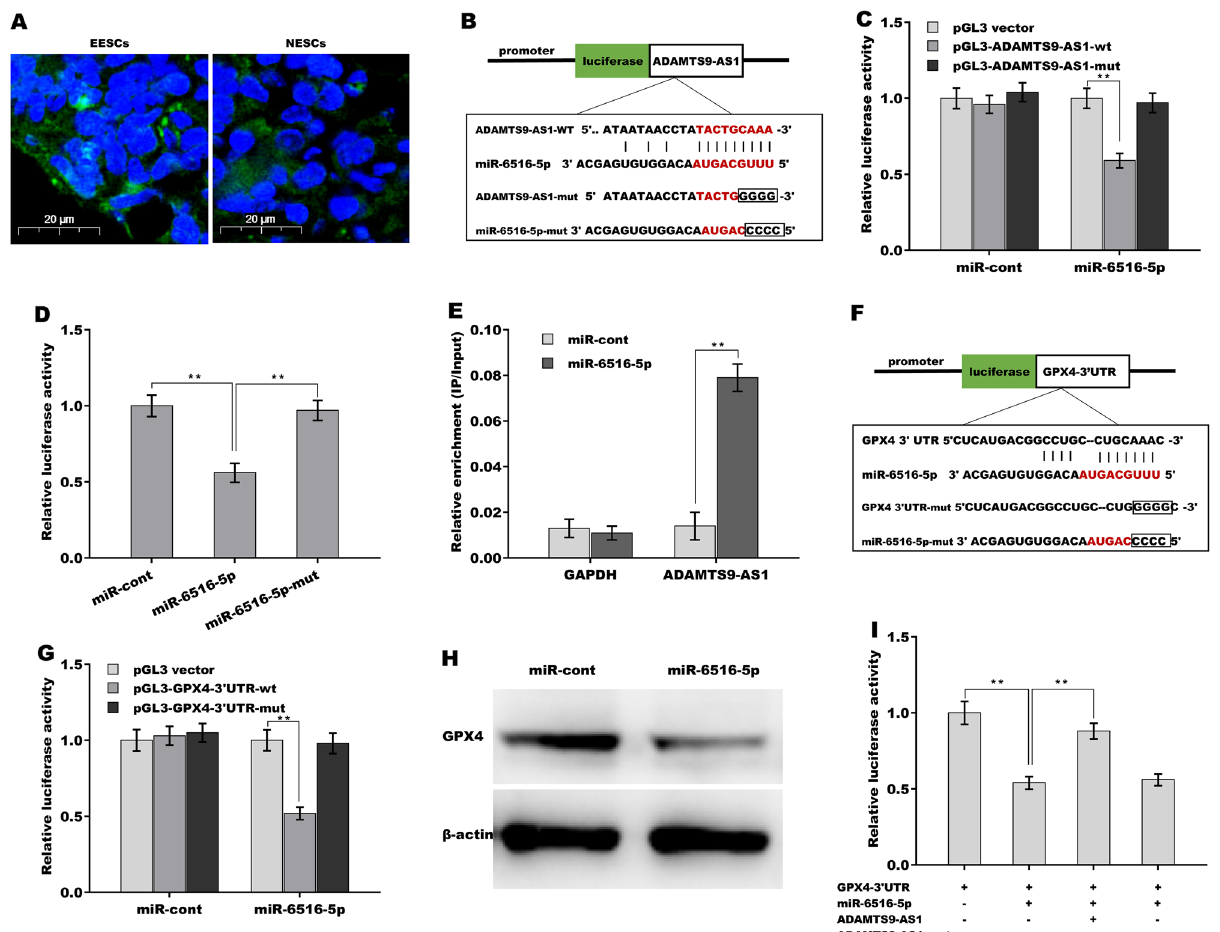
Figure 5. ADAMTS9-AS1 acted as a ceRNA by sponging miR-6516-5p. ( A ) The subcellular localization of ADAMTS9-AS1 in EESCs and NESCs was analyzed using an RNA-FISH assay. Probes targeting ADAMTS9-AS1 were stained green, and DAPI was used to stain the nuclei of EESCs and NESCs. ( B ) Schematic representation of the predicted binding sites of miR-6516-5p in the ADAMTS9-AS1 sequence. ( C ) Luciferase activity was assessed using a dual-luciferase reporter assay in ESCs cotransfected with miR-6516-5p and recombinant luciferase reporter plasmids containing ADAMTS9-AS-wt (or ADAMTS9-AS-mut). Renilla luciferase was used as the internal control for normalizing transfection efficiency, and the data are shown as the relative ratio of firefly luciferase activity. ( D ) Luciferase activity was assessed using a dual-luciferase reporter assay in ESCs cotransfected with miR-6516-5p (or miR-6516-5p-mut or miRcont) and recombinant luciferase reporter plasmids containing ADAMTS9-AS-wt. ( E ) The direct combination of ADAMTS9-AS with miR-6516-5p was assessed through an RNA pull-down assay using 3 ′ -biotinylated miR-6516-5p as bait. ( F ) Schematic representation of the predicted binding sites of miR-6516-5p in the GPX4-3’UTR sequence. ( G ) Luciferase activity was assessed using a dual-luciferase reporter assay in ESCs cotransfected with miR-6516-5p (or miRcont) and recombinant luciferase reporter plasmids containing GPX4-3’UTR-wt (or GPX4-3’UTR- mut). ( H ) The protein expression of GPX4 was assessed using western blot analysis in ESCs after miR-6516-5p overexpression. ( I ) Luciferase activity was assessed using a dual-luciferase reporter assay in ESCs cotransfected with miR-6516-5p and luciferase reporters containing GPX4-3’UTR, ADAMTS9-AS-wt, or ADAMTS9-AS- Mut. * p < 0.05, ** p <